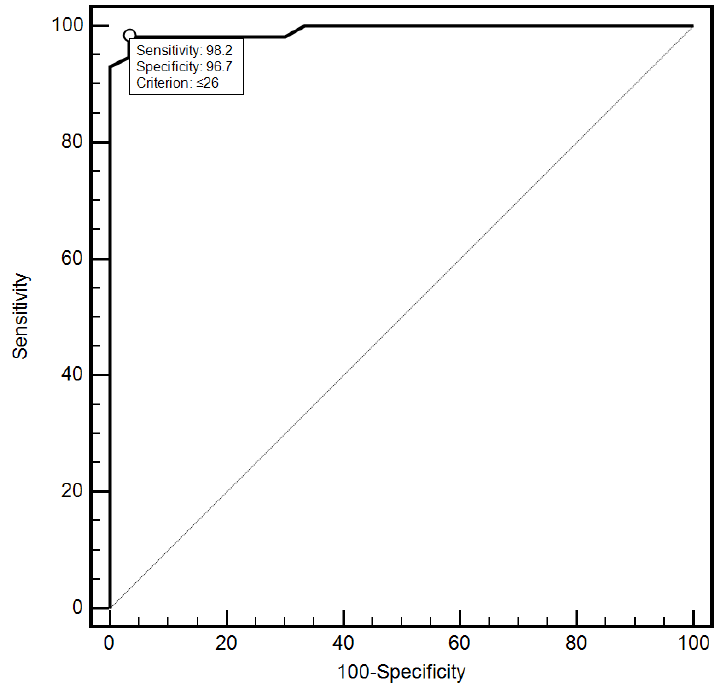
7 Figure 7. Assessment of the diagnostic usefulness of the cervical length parameter in early detection of preterm labor using the ROC curve.